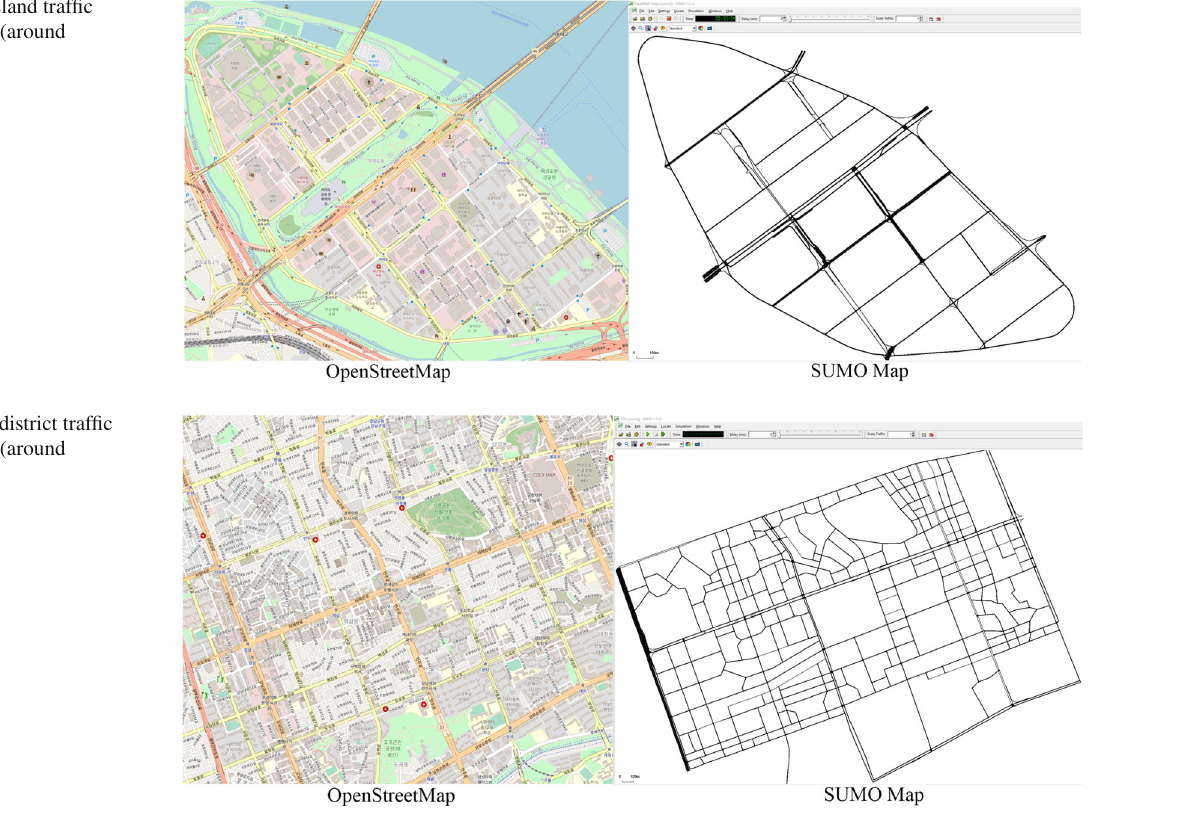
Fig. 3 Yeouido island traffic network scenario (around 4.15 km 2 )